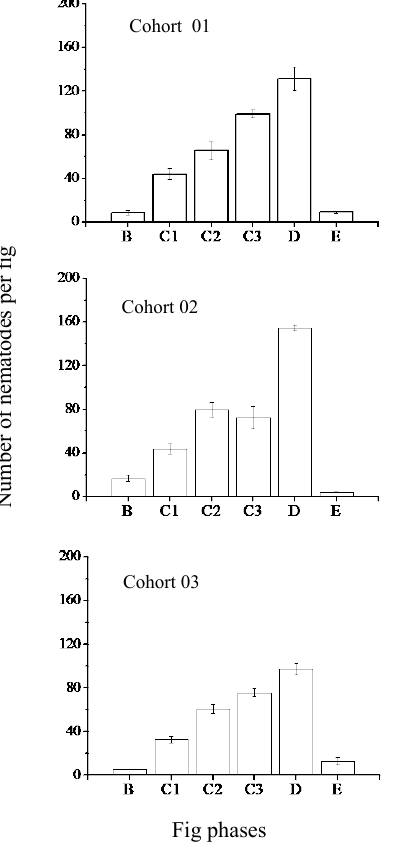
Figure 3. Nematode population sizes during the development of male figs of Ficus hispida . All nematode species and stages combined (means ± SE, N = 5 to 6 figs for every phase). Pollinator fig wasp vectors of the nematodes enter during the B phase. Phases C1–C3 cover the early, middle and